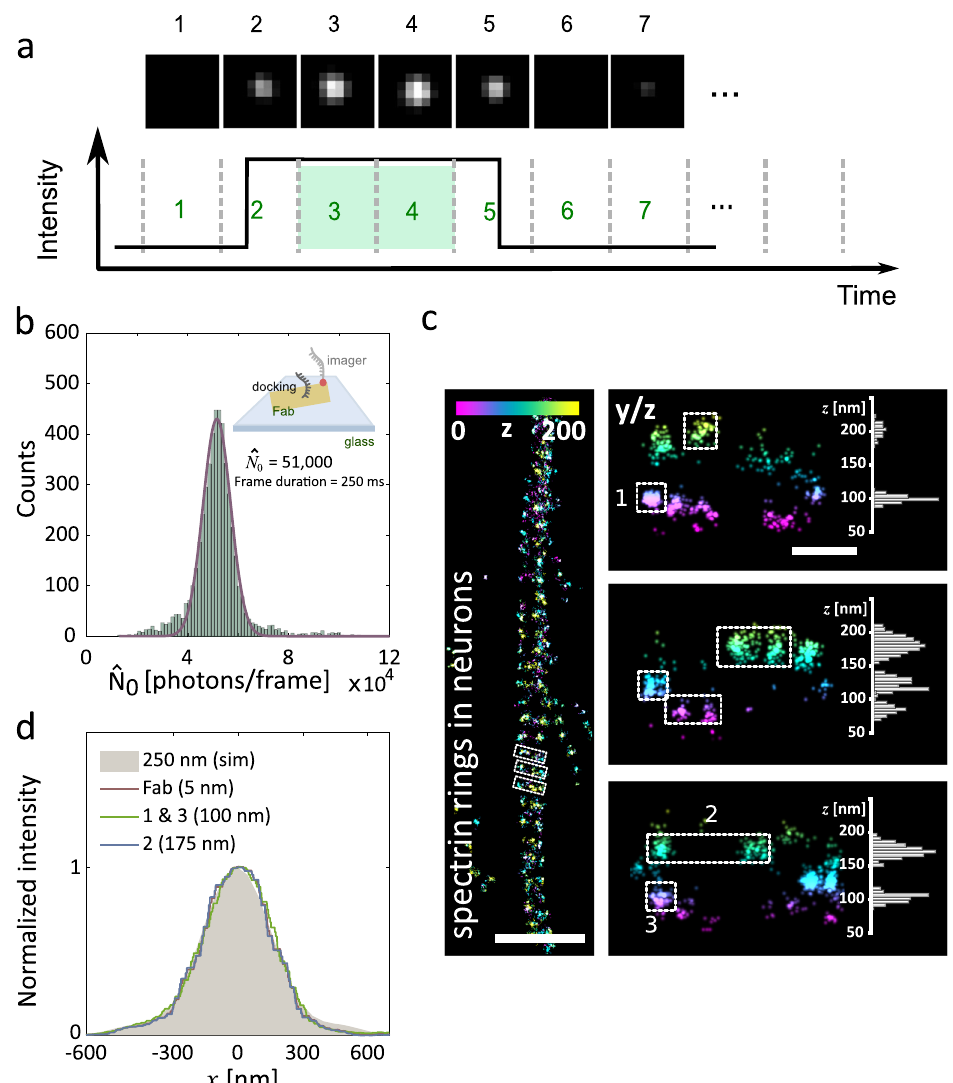
Fig. 2 Data analysis and z assessment via SIMPLER. a Single molecules are detected and localized using any single-molecule localization microscopy software. In the case of non-uniform illumination experiments (i.e. due to Gaussian shape of the excitation beam), the number of photons of each localization is corrected to the local excitation intensity (see ‘ Methods ’ ). Next, a frame- fi ltering step is performed to only use localizations that lasted at least three frames and compute their photon count per frame excluding potentially misleading fi rst and last frames. b Histograms of photons counts for ATTO655, imaged using DNA-PAINT, with a sample of DNA-labelled (docking strand) Fab fragments deposited over a coverslip. The imaging area was 16 × 16 µ m 2 with a 4-Hz acquisition frame rate (see ‘ Methods ’ ). Inset: schematic representation of the experimental conditions. c β 2-spectrin rings in hippocampal neurons. Left: top view ( xy ). Right: magni fi ed side-views ( yz ) of the boxed regions in the top view, together with axial pro fi les of the boxed areas. Localizations are colour-coded according to their z -position. Top view and side-views have the same z -colour scale. The ring-like structure shown was similarly reproduced in several axons from three independent experiments. d Normalized image pro fi les of single emitters located at different axial positions ( z = 5, 100 and 175 nm) within the TIRF region along with the simulated pro fi le for a rotating dipole located at z = 250 nm. Experimental pro fi les were obtained from samples of Fab fragments adsorbed to the coverslip ( z = 5 nm) and β 2-spectrin rings in hippocampal neurons ( z = 100 and 175 nm, numbered regions in c ). Scale bars represent 1 µ m ( c , top view); and 100 nm ( c , side view). Number of localizations kept after frame- fi ltering step: ( b )